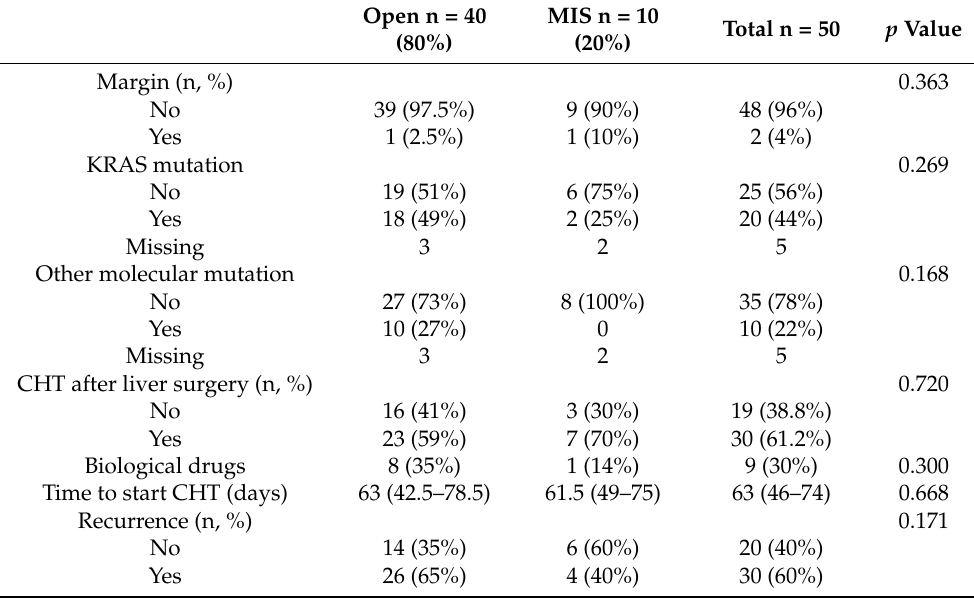
Table 5. Pathological results and other oncological